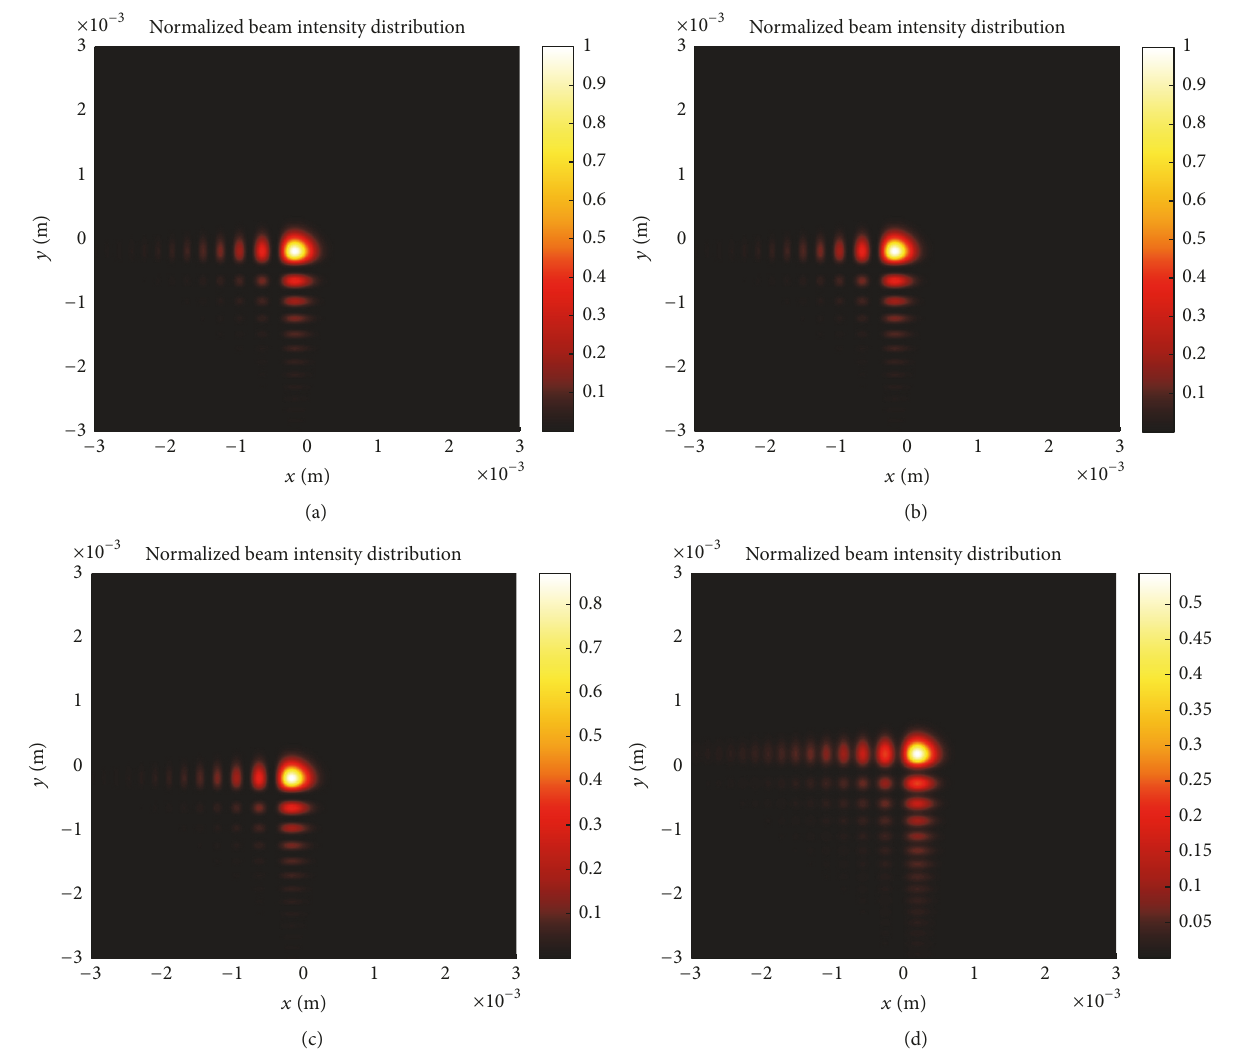
Figure 2: Transverse normalized intensity distribution of incident Airy beam and three kinds of emerging beams on output surface. (a) IncidentAirybeamdistribution,(b)emergingAirybeamdistribution,DNM’s 𝜔 𝑝𝑒 = 𝜔 𝑝𝑚 = 2𝜋 ] ×√2.55 ,(c)emergingAirybeamdistribution, DNM’s 𝜔 𝑝𝑒 = 𝜔 𝑝𝑚 = 2𝜋 ] × √3.1 , and (d) emerging Airy beam distribution, DNM’s 𝜔 𝑝𝑒 = 𝜔 𝑝𝑚 = 2𝜋 ] × √2